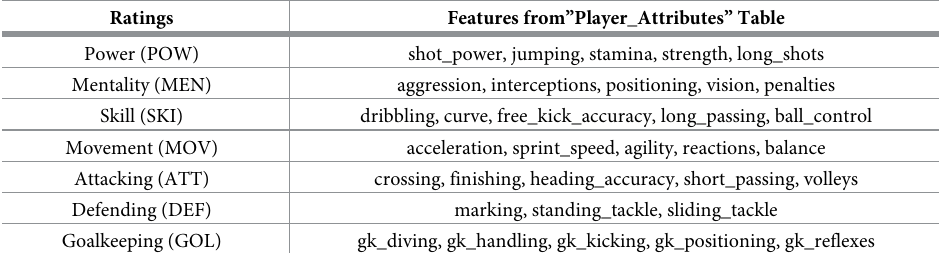
Table 2. FIFA ratings grouping assignment [31].